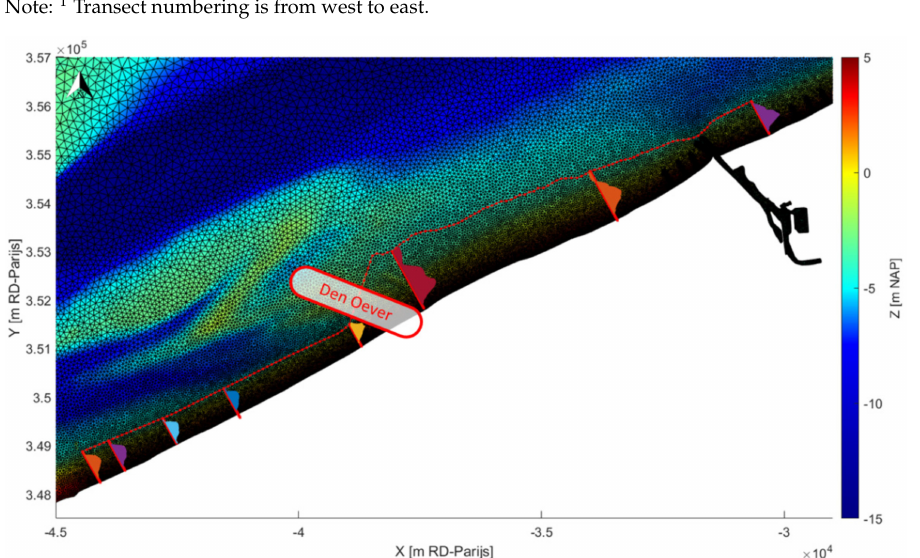
Figure 8. Location of transects defined to gather output from Scaldis-Coast on the littoral drift in the study